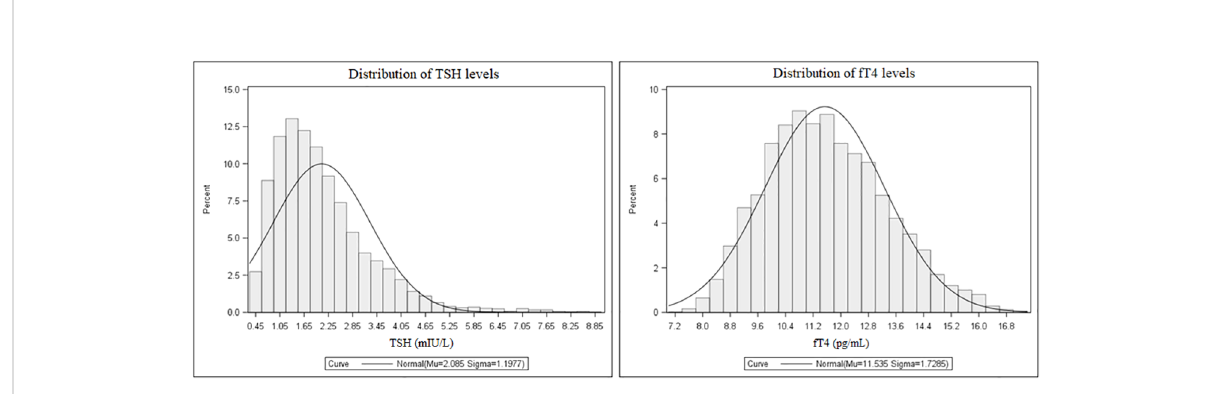
FIGURE 2 Distribution of TSH (left) and fT4 levels (right) in the whole